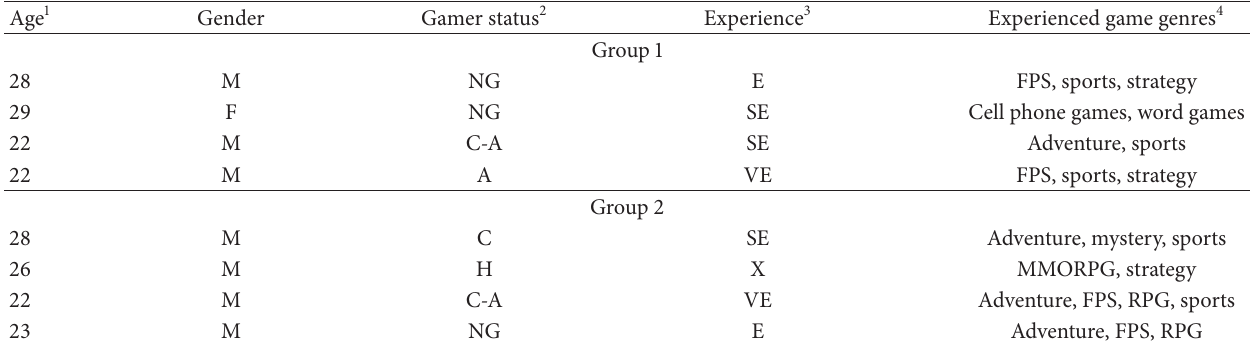
Table 1: Summary of player demographics.